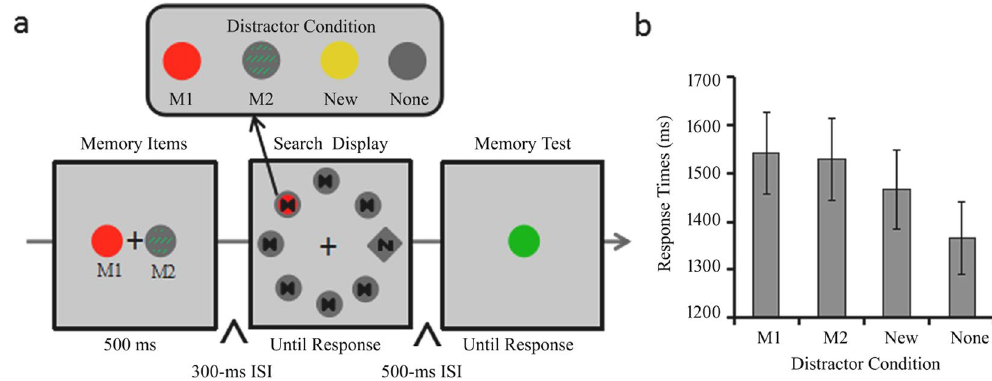
Figure 1. Trial sequences and results of Experiment 1. ( a ) The sequence of events with four possible distractor conditions in a trial of Experiment 1 (the M1 distractor condition: the disk’s color and texture was the same as the left memorized item; the M2 distractor condition: the disk’s color and texture was the same as the right memorized item; the New distractor condition: the disk was a new solidly colored disk; the None